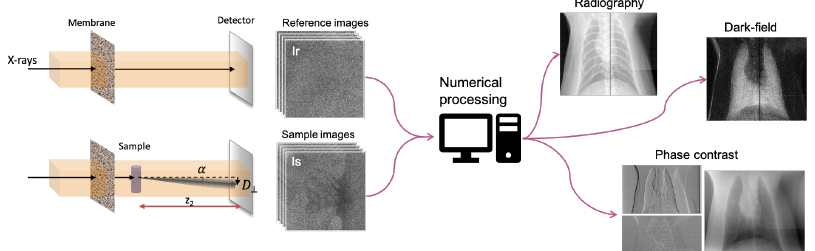
Figure 11. MoBI principle outline. From several acquisitions of the membrane alone and membrane plus sample in the path of the beam, numerical processing allows one to retrieve attenuation dark-field and phase contrast